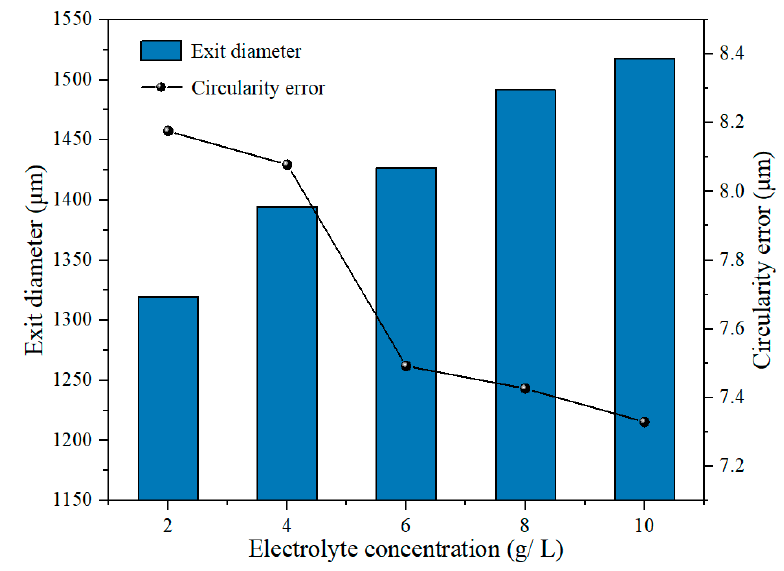
Figure 15. Variation of exit diameter and circularity error with electrolyte concentration in electrochemical reaming.